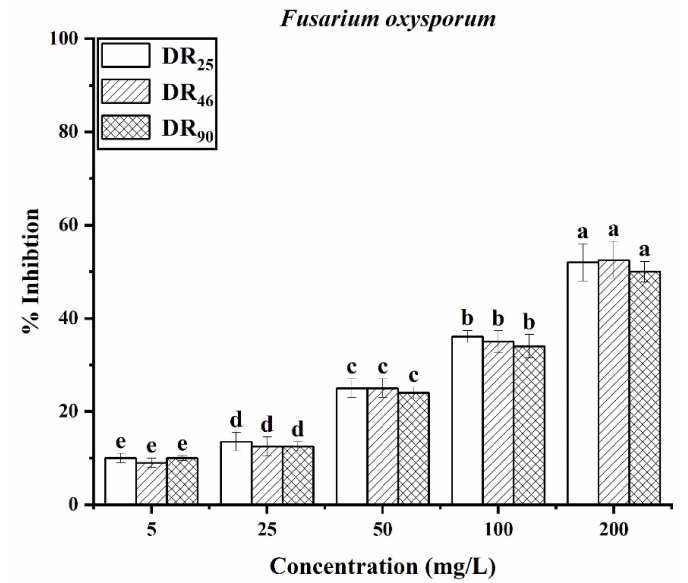
Figure 5. The inhibition rate of rhamnolipids against spores of F. oxysporum . Error bars represent standard deviation (SD), and letters indicate significant difference at α = 0.05 according to